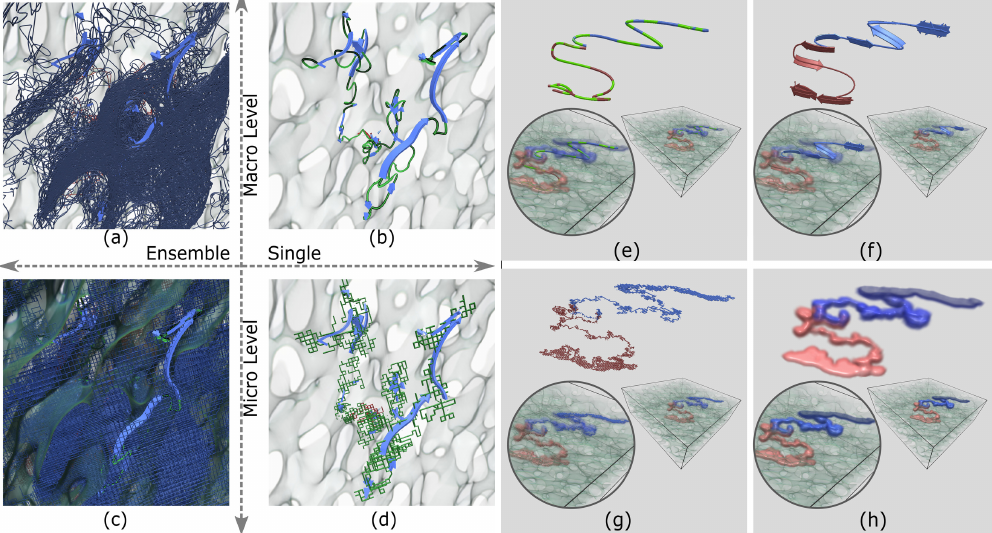
Figure 6. Trajectory visualization on different levels of abstraction. ( a , c ) visualization of multiple charge trajectories together with ribbon arrows giving a hint of the general trend of the charge movement. ( b , d ) show one selected trajectory with micro and macro abstraction level and rendering options. ( e – h ) show single trajectory abstractions. ( e ) The stripe pattern is a measure for the effective velocity of the charge. The time the charge needs for one stripe is constant. ( f ) Arrow representation added to simplified trajectory representation. ( g ) Direct rendering of raw trajectory represented using tube rendering. ( h ) Charge coverage volume visualization of single